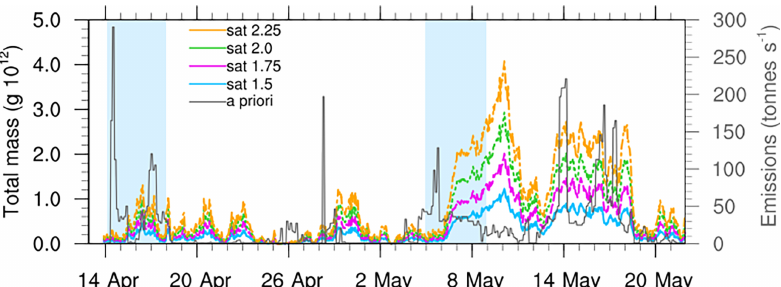
Figure 3. Left axis shows the total mass of ash in the domain for the four satellite retrievals with different size distribution assumptions (sat 1.5–2.25), for every hour over the entire Eyjafjallajökull eruption period. Right axis shows the emissions in the a priori estimate calculated from observed plume height at the volcano. The blue shaded areas indicate the periods studied in the